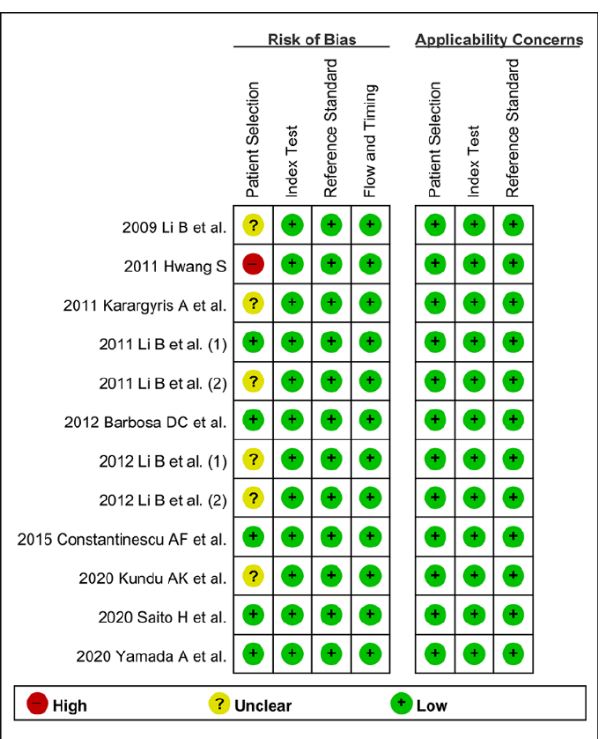
Figure 2. Summary graph of quality in methodology for the computer-aided diagnosis of gastroin- testinal protruded lesions in wireless capsule endoscopy. (+) denotes low risk of bias, (?) denotes unclear risk of bias, ( − ) denotes a high risk of bias.